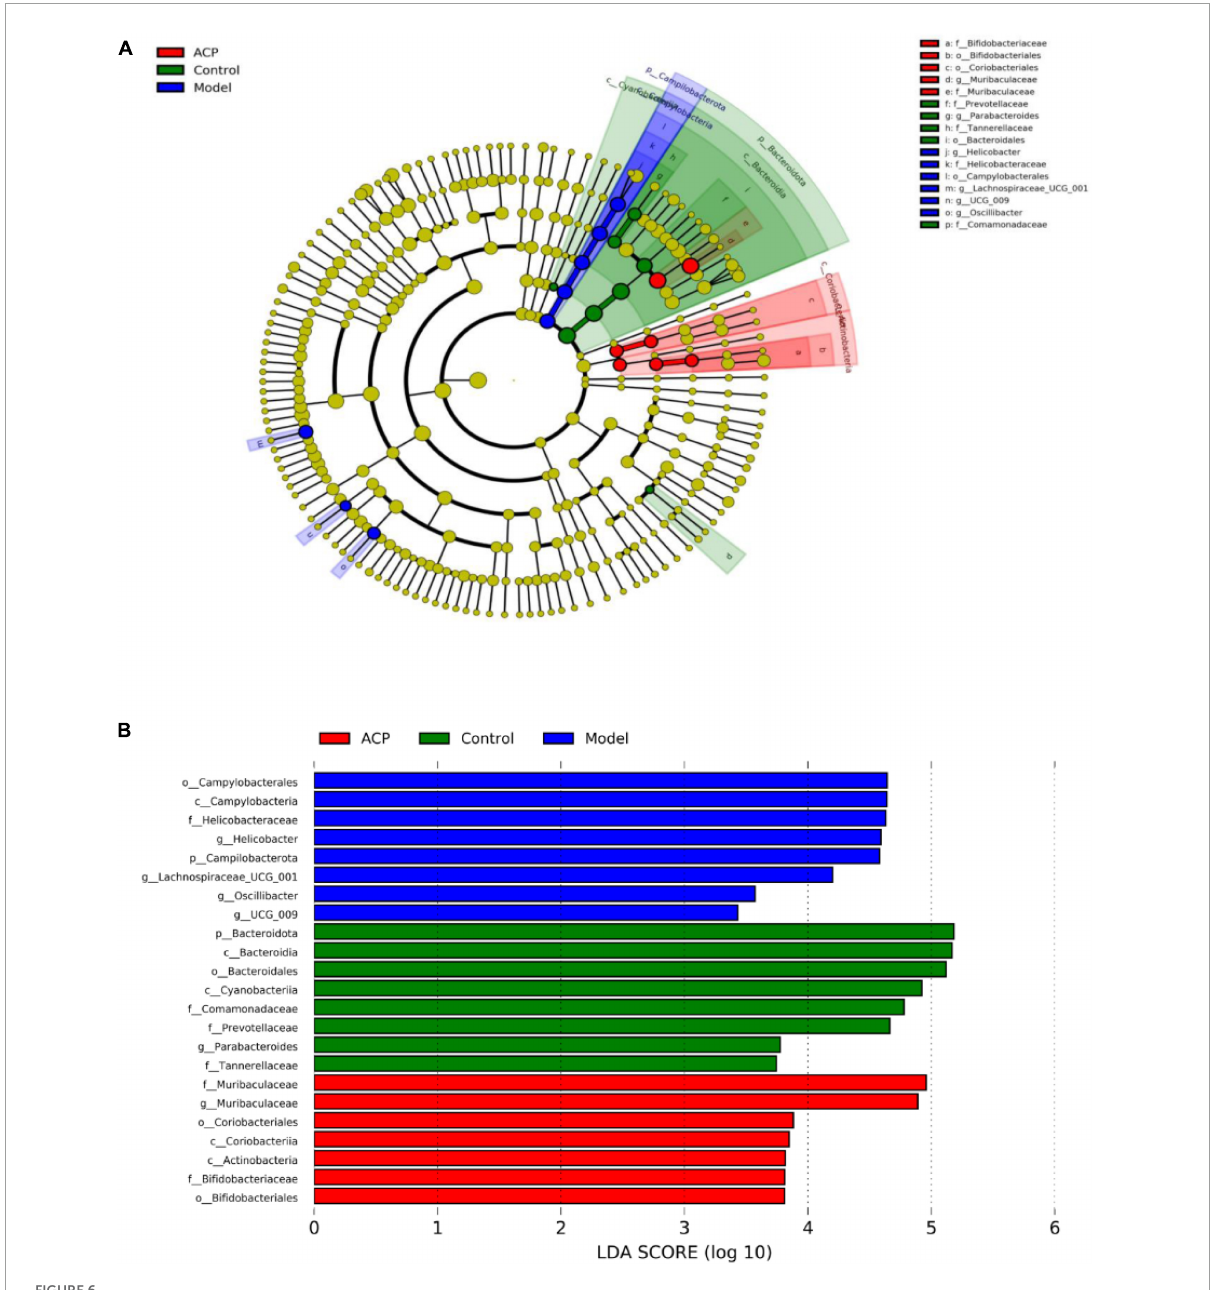
FIGURE6 Linear dis-criminant analysis effect size (LEfSe) analysis among the control, model, and Auricularia cornea var. Li. polysaccharides (ACP) group. (A) Taxonomic cladogram and (B) LDA histogram (LDA >